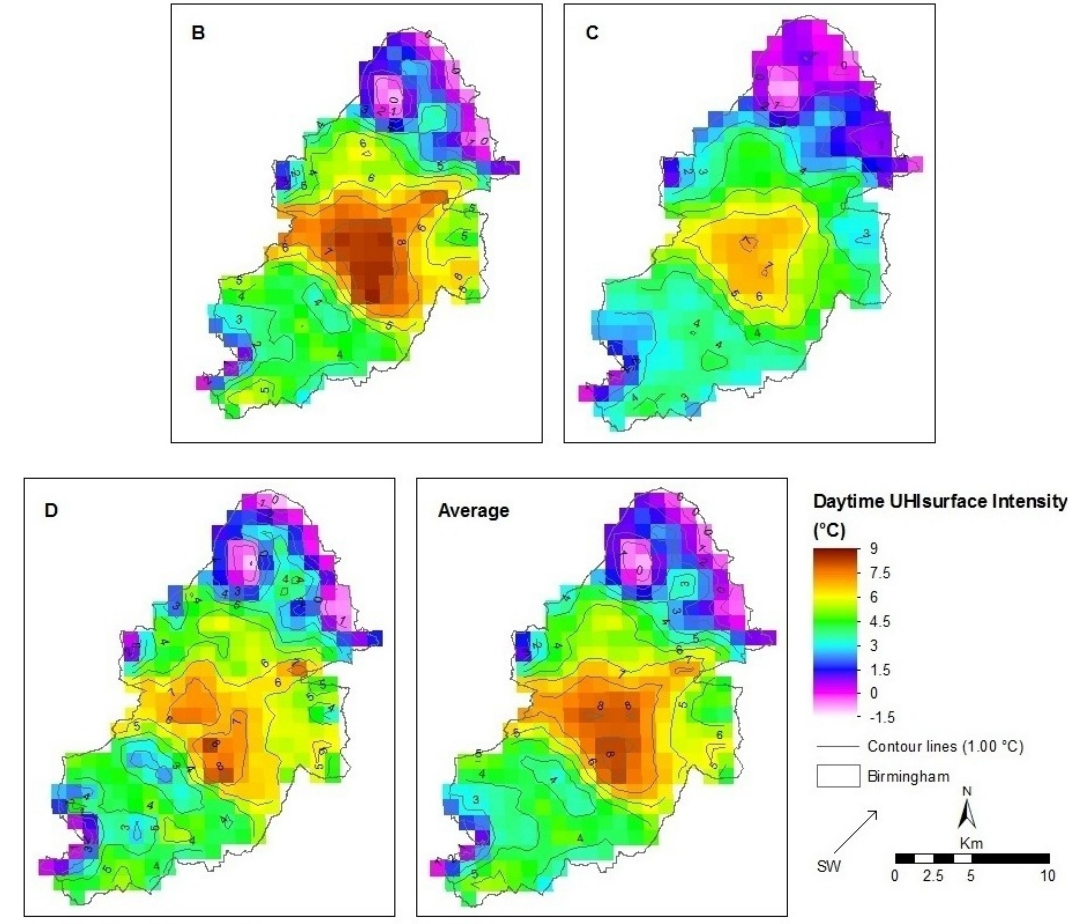
Figure 2. Daytime UHI surface intensity, for Pasquill-Gifford Stability Classes ( B ); ( C ) and ( D ); and Average for June, July, August 2013 and prevailing wind direction for the period. Based on MODIS Aqua LST product.